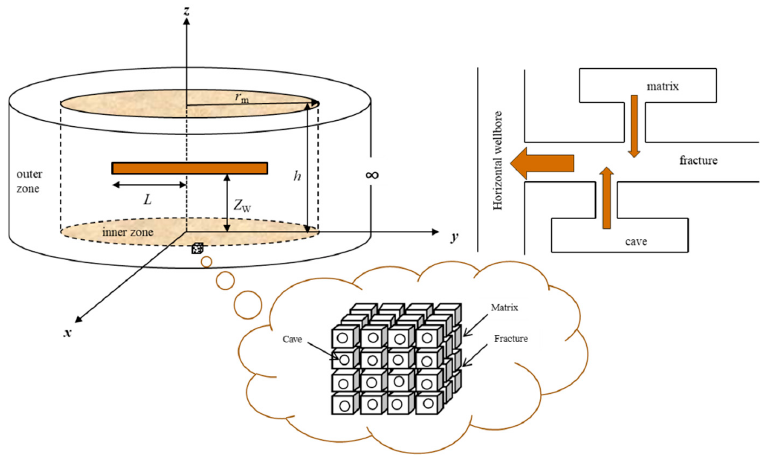
Figure 2. Physical model of triple medium composite reservoir.